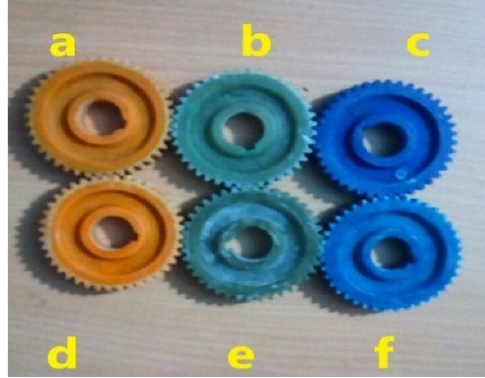
Figure 2. ( a ) Flax fiber-reinforced polyester gear (FFRPG)-20. ( b ) Sisal FRPG (SFRPG)-20. ( c ) Glass FRPG (GFRPG)-20. ( d ) FFRPG-15. ( e ) SFRPG-15. ( f ) GFRPG-15.